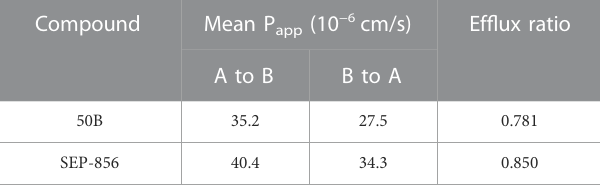
TABLE 2 Membrane permeability of 50B and SEP-856.